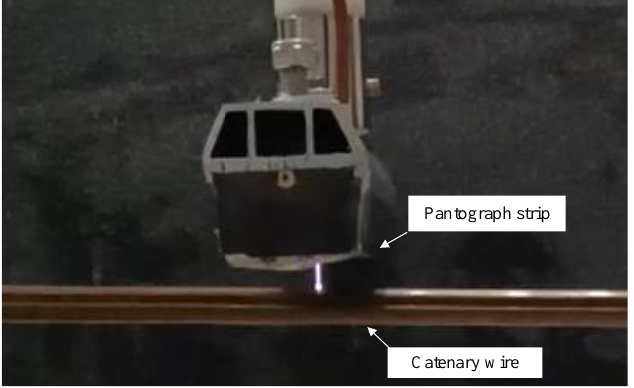
Figure 2. Arcing discharge between the pantograph strip and catenary wire.